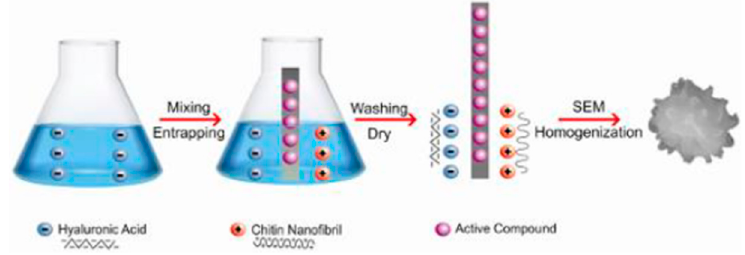
Figure 11. The gelation method.